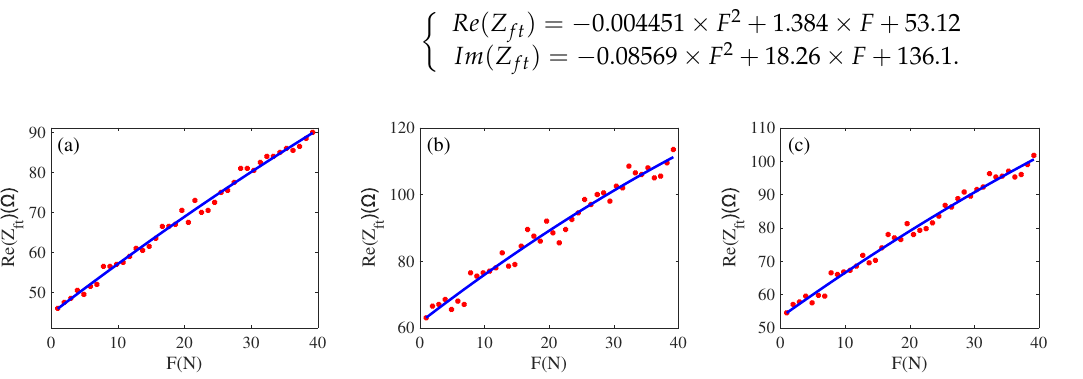
Figure 14. ( a ) Load and real part by an inscribed circle; ( b ) Load and real part by a circumcircle; ( c ) Load and real part by